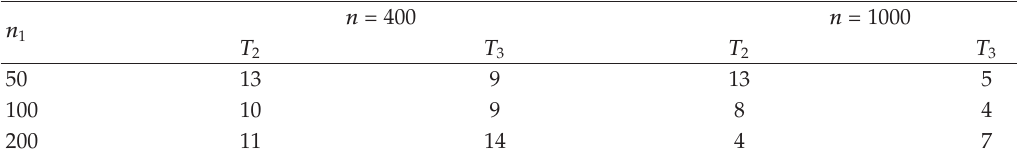
Table 2: Integrated absolute di ff erence of the cumulative distributions (cid:7) × 100 (cid:8) of T 1 ∼ N (cid:7) 0 ,M − 1 (cid:7) ξ ∗ ,θ (cid:8)(cid:8) , ∼ N (cid:7) 0 ,M − 1 (cid:7) ξ A ,θ (cid:8)(cid:8) , and T ∼ UQ versus the approximate cumulative distribution of T 2 3 via Monte Carlo simulations for various n 1 and various large sizes of n . The values θ (cid:6) 1, x 1 (cid:6) 2, σ (cid:6) . 5, a (cid:6)